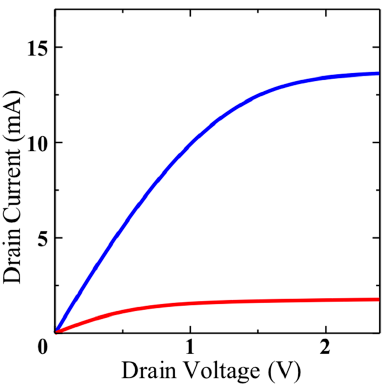
Figure 3. Pixel transistor characteristics of transistors with dimensions of 5 µm × 5 µm (blue) and 2 µm × 2 µm (red).